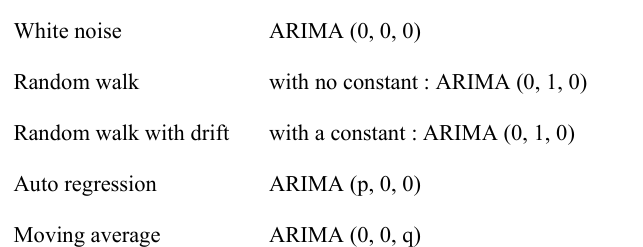
Table 3. Exceptional cases of ARIMA White noise